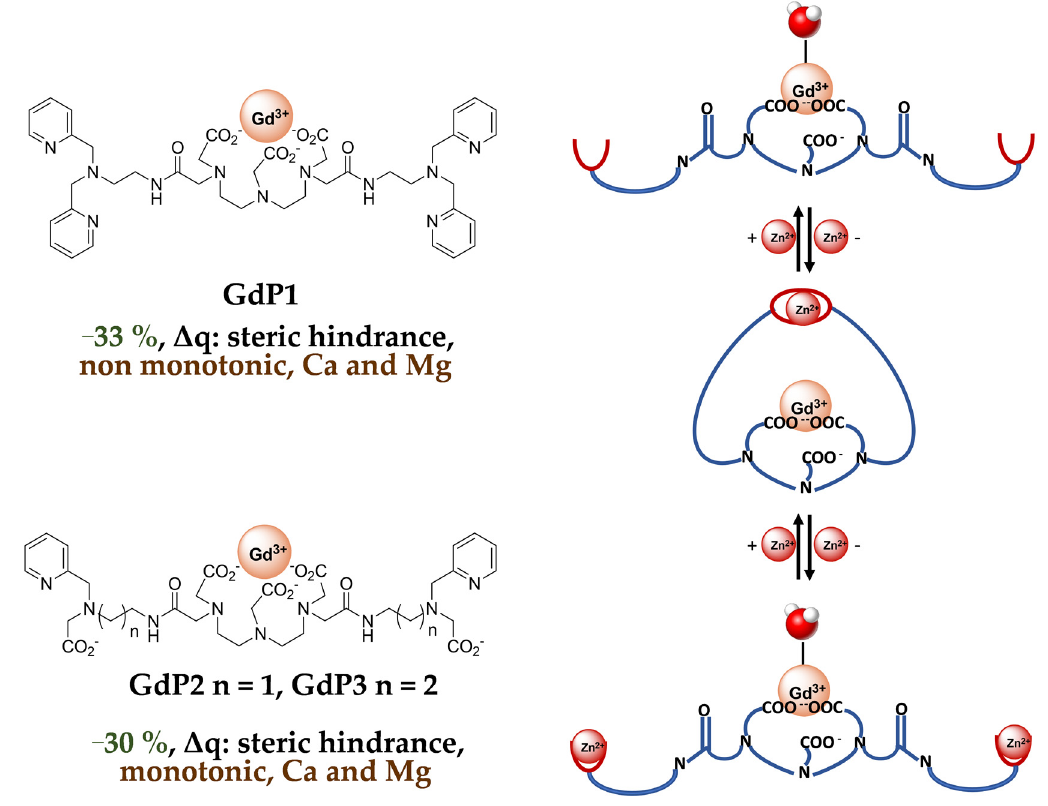
Figure 5. Zinc responsive contrast agents based on GdDTPA-bisamide systems developed by Nagano et al. In green ( ∆ r 1 ), black (mechanism of response), brown (response to Zn 2 + (1 eq.) and